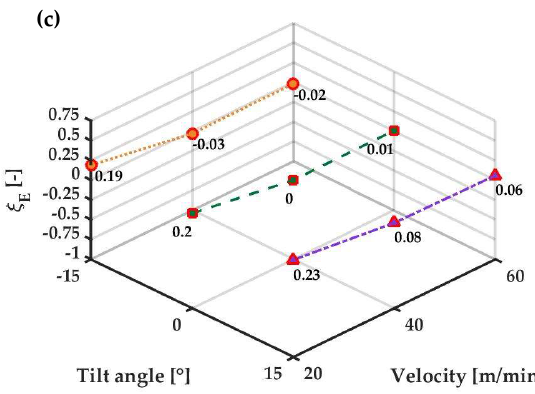
Figure 14. Energy effectiveness coefficient at section γ for AC mass flow inlet ( a ) 3%; ( b ) 5%; ( c ) 7%.